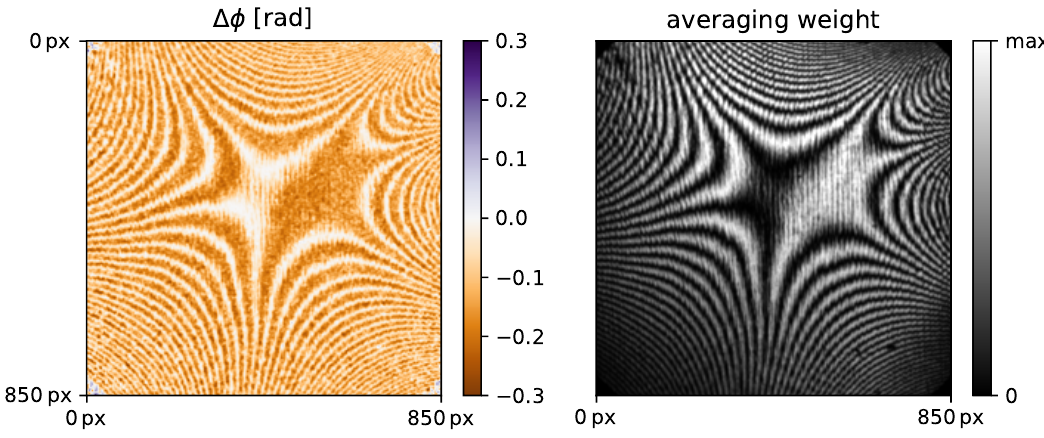
Figure 6. Example of sampling phase deviations (left) obtained from Equation 14 (cf. also Figure 3) for the first frame of the phase stepping series shown in Figure 1 with corresponding importance weights ( right ) as defined by Equation (16). White regions (0 on the colorbar) in the ∆ φ map ( left ) correspond to samples close to or exactly on turning points of the fitted sinusoids, where phase deviations cannot be effectively determined. These areas get little weighting in the determination of the average phase deviation as can be seen by the corresponding dark fringes in the weighting map on the